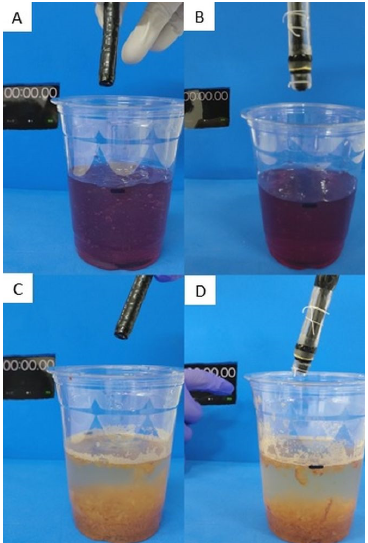
Figure 4. Suction test for a soft jelly made of agar: ( A ) standard endoscope vs. ( B ) our hand-made device. Suction test for grated apple: ( C ) standard endoscope vs. ( D ) our device.